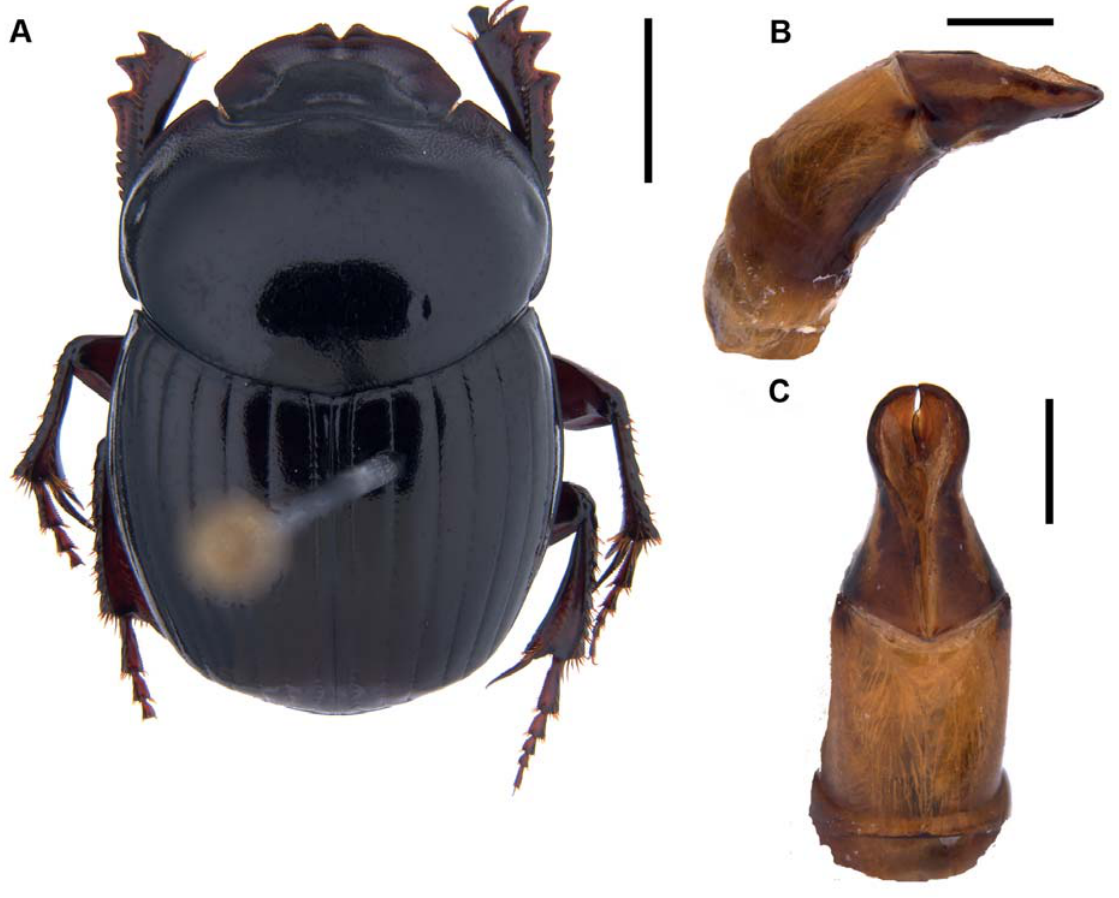
Fig. 6. Canthidium feeri sp. nov., holotype (CEMT) A . Dorsal view. B . Lateral view of aedeagus. C . Dorsal view of aedeagus. Scale bars: 1